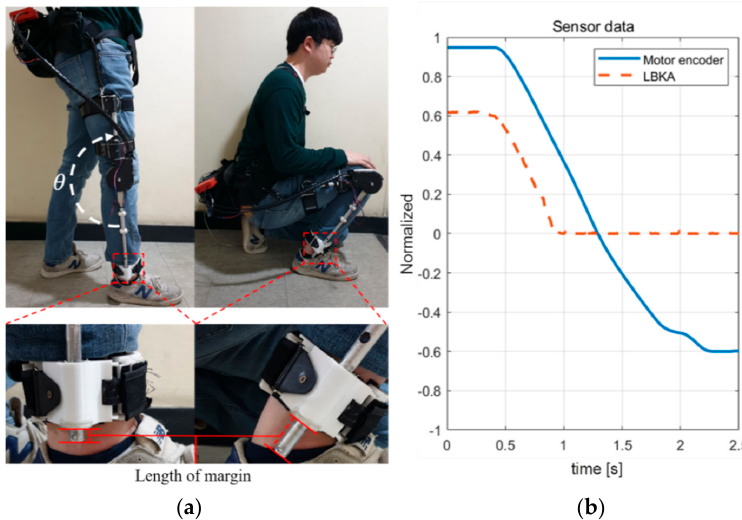
Figure 7. Range of motion experiment snapshot. As the knee is bent, the length of the lower frame of the exoskeleton decreases. This structure does not limit the wearer's range of motion, so it is possible for the wearer to sit down fully. ( a ) Snapshot of the experiment and detailed view of the length of margin change in the ankle part. The angle measured by the encoder of the motor is expressed as θ , ( b ) Graph of measured data.